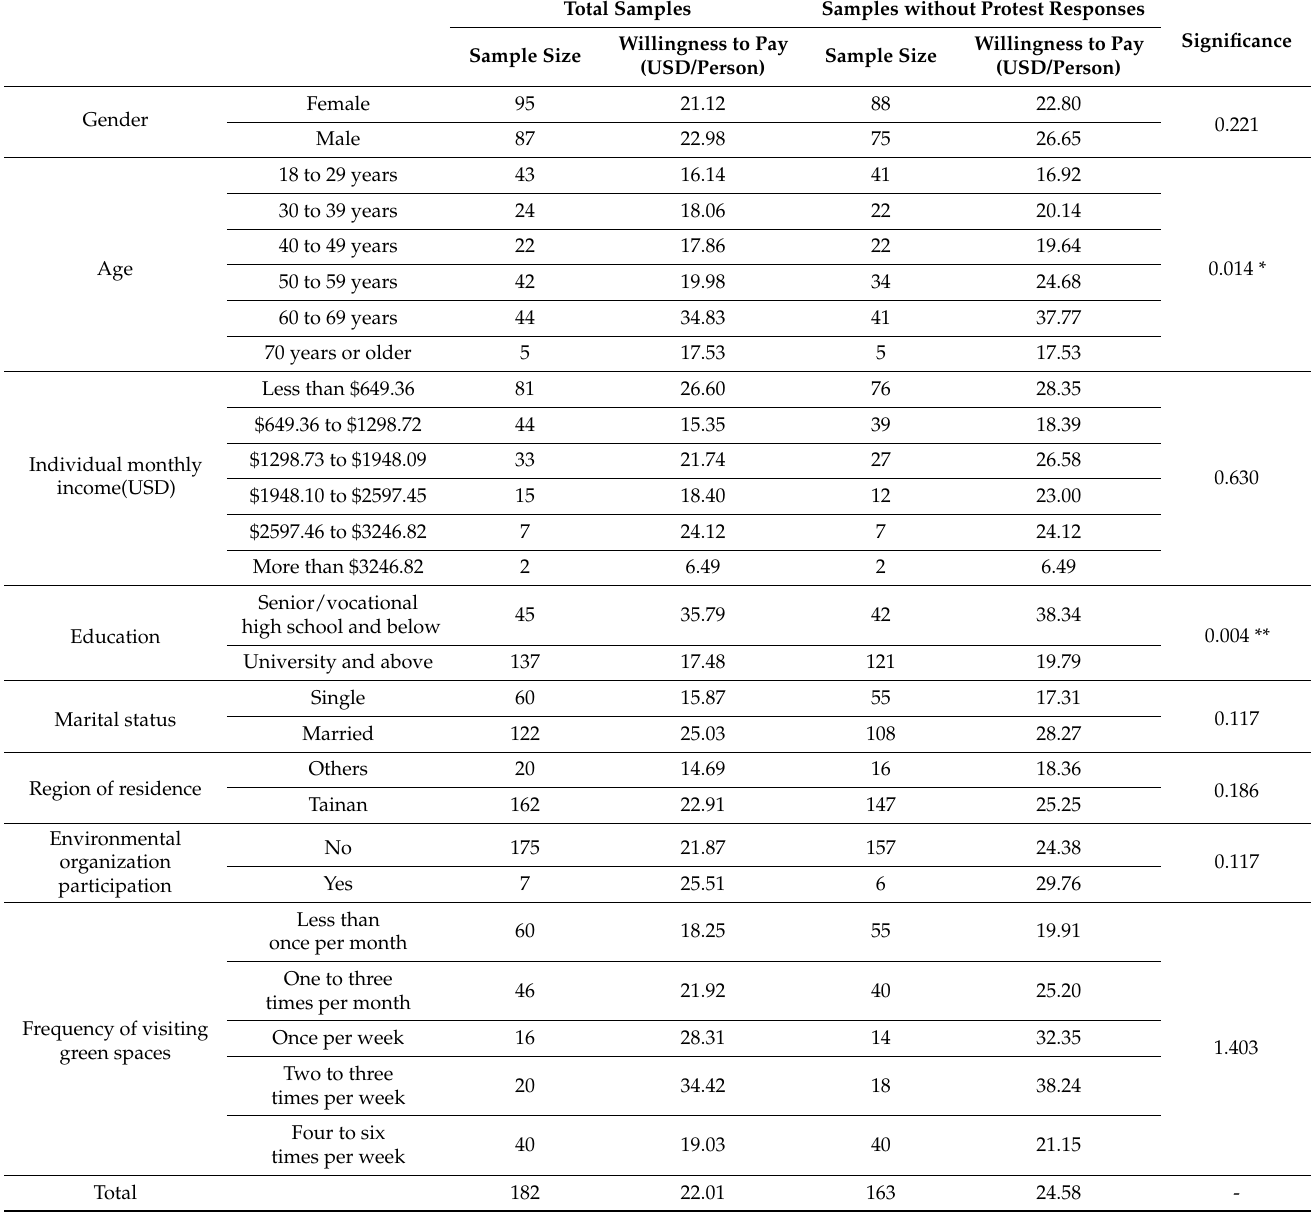
Table 5. WTP for ecological conservation with respect to socioeconomic